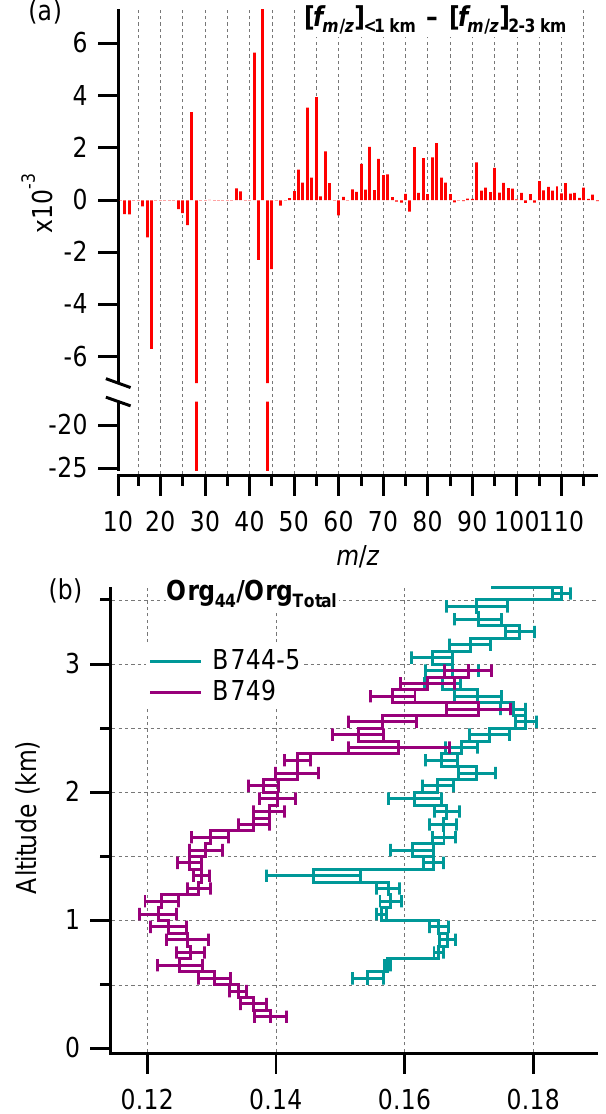
Figure 6. (a) Difference in normalised organic mass spectra be- tween the altitude ranges of less than 1km and between 2 and 3km. (b) Trend in Org 44 /Org Total with altitude for the two contrasting cases, with standard